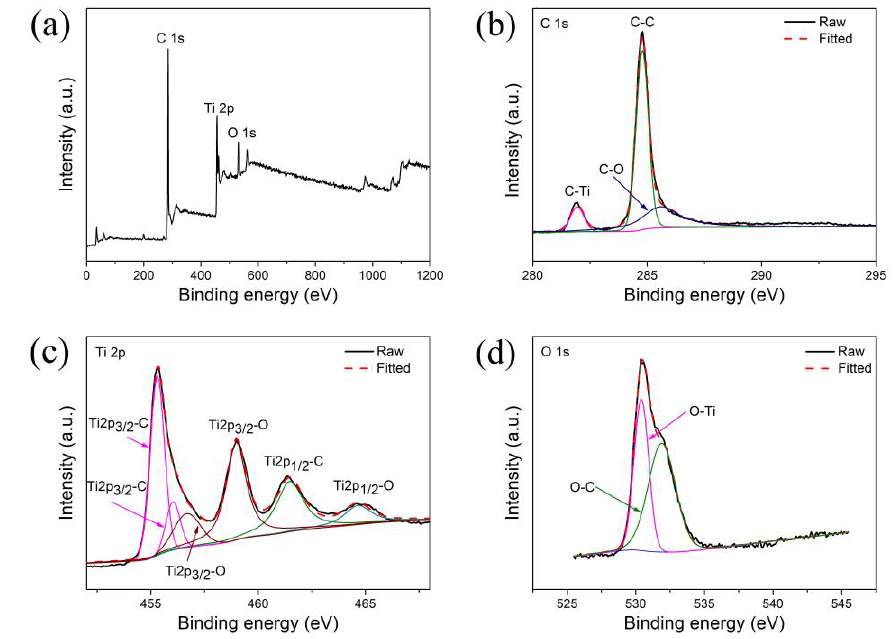
Figure 3. XPS spectra of TiC-coated GF: ( a ) full spectra, ( b ) C1s, ( c ) Ti2p, ( d ) O1s.